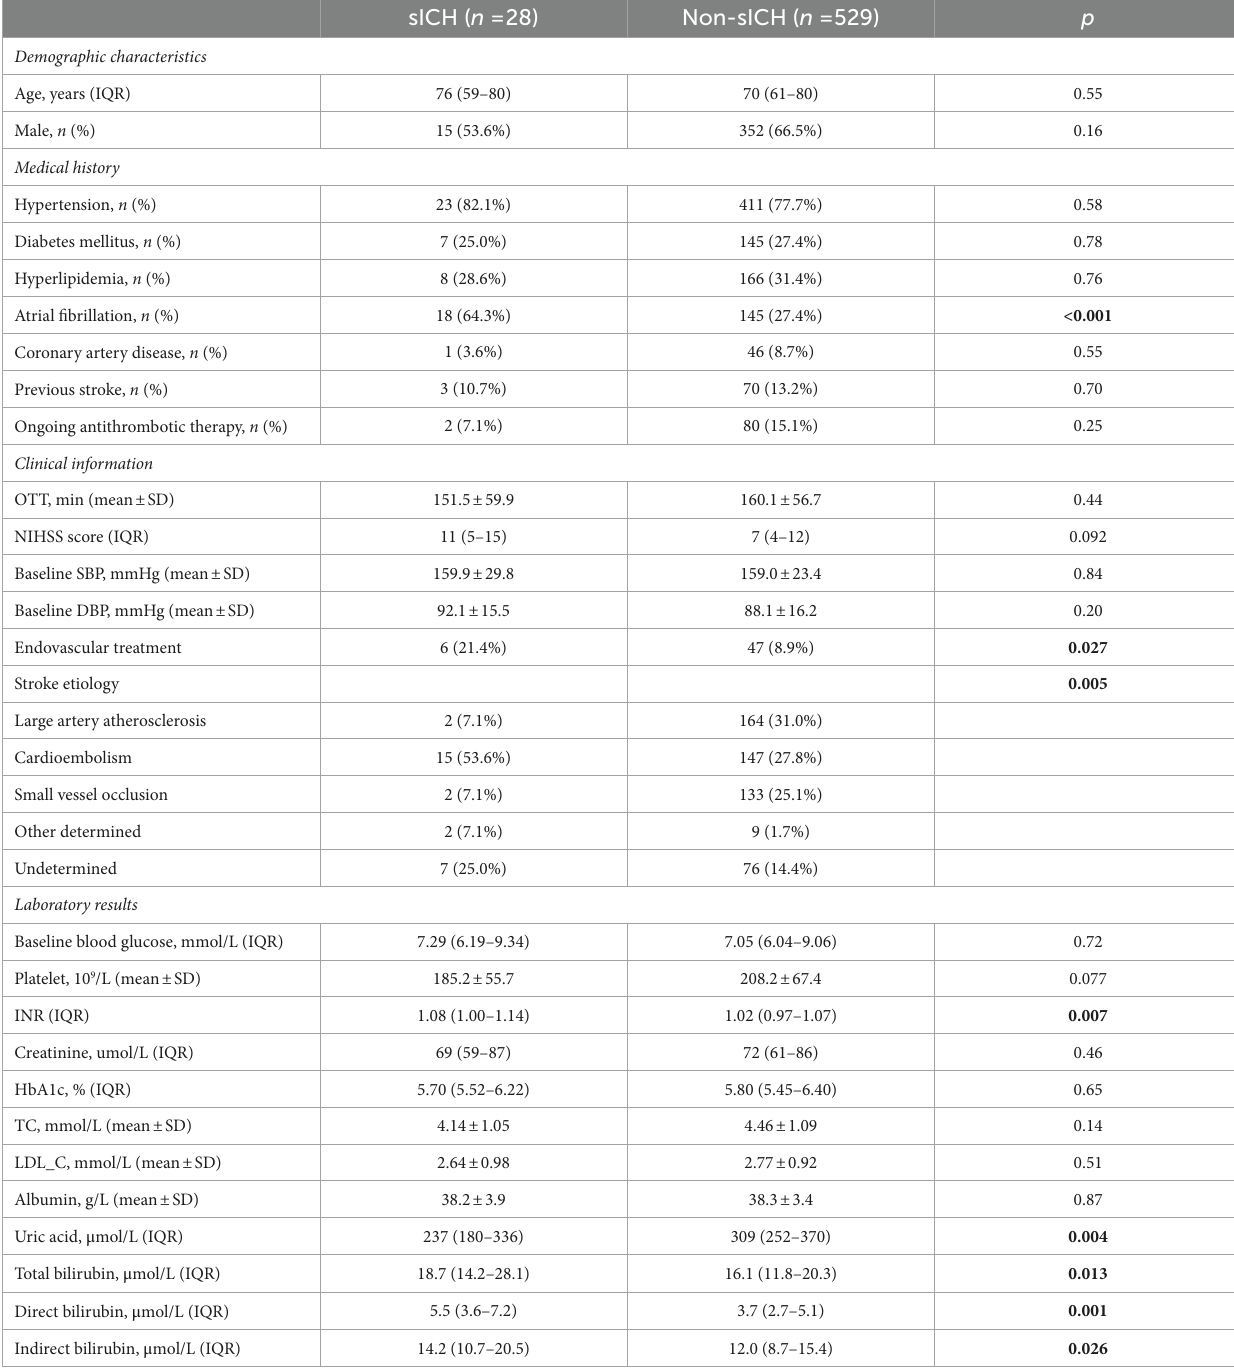
TABLE 2 Clinical characteristics of patients, stratified by the presence of sICH. sICH ( n = 28) Non-sICH ( n = 529)